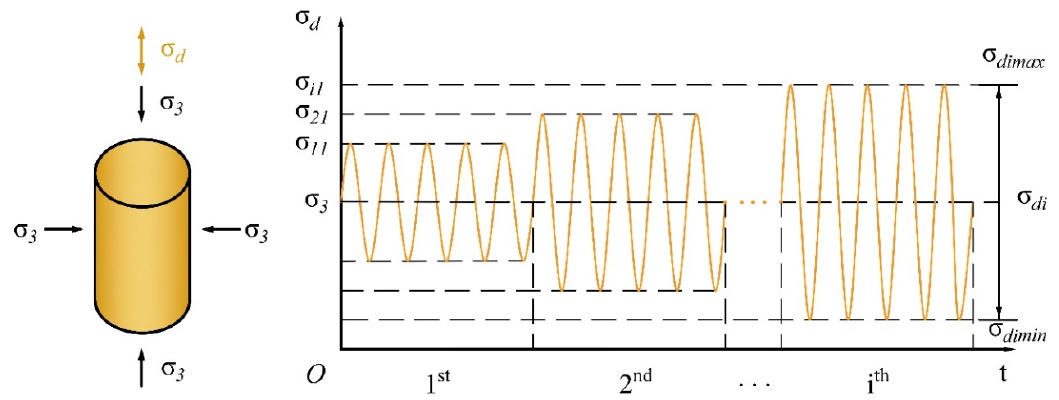
Figure 2. Application diagram of multistage cyclic axial loading. Table 2. Experimental conditions of cyclic triaxial test.